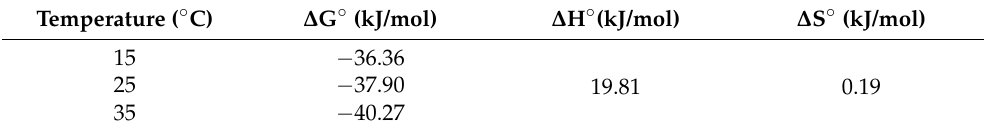
Table 1. Thermodynamic parameters derived for the adsorption of ciprofloxacin by colemanite. Temperature ( ◦ C) ∆ G ◦